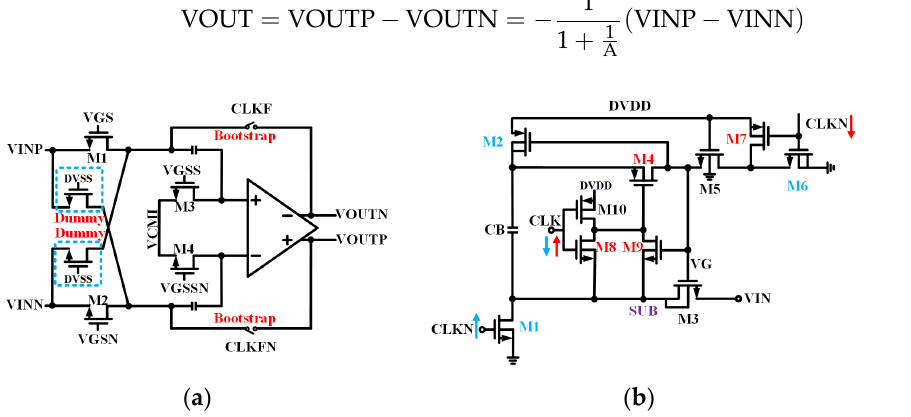
Figure 8. ( a ) Flip-around SHA schematic. ( b ) Bootstrapped switches, used in the SHA and